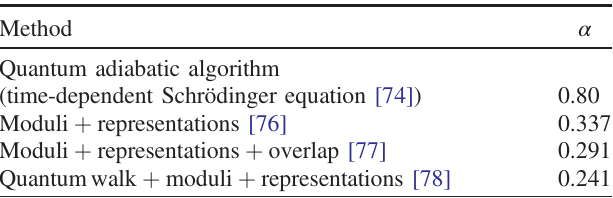
TABLE I. Runtime scaling exponent for different methods to solve the number partitioning problem. The scaling of simulated annealing is very poor and is not shown here. This is because for simulated annealing to work at all it has to be run at very high temperatures to overcome the enormous energy barriers present in this problem. However, at these high temperatures, SA behaves almost like random sampling and, hence, its scaling is almost that of exhaustive search. The value α ¼ 0 . 8 for the solution of the time-dependent Schrödinger equation was initially obtained in Ref. [74] and is significantly better than the nearly exhaustive- search behavior of SA. This mirrors the situation we encounter for the weak-strong cluster networks. We also give references for the state-of-the-art classical and quantum